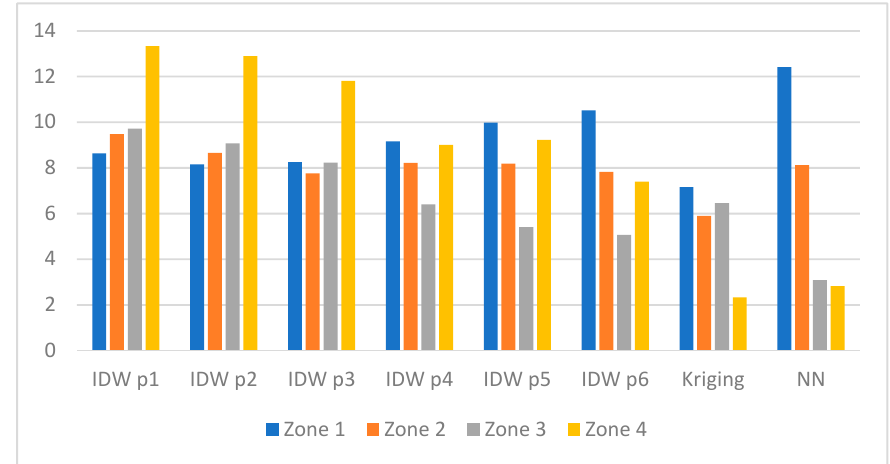
Figure 5—Test_13a, scenario with 13 measurement sensors, Figure 6—Test_20c, scenario with 20 measurement sensors, Figure 7—Test_26a, scenario with 26 measurement sensors.